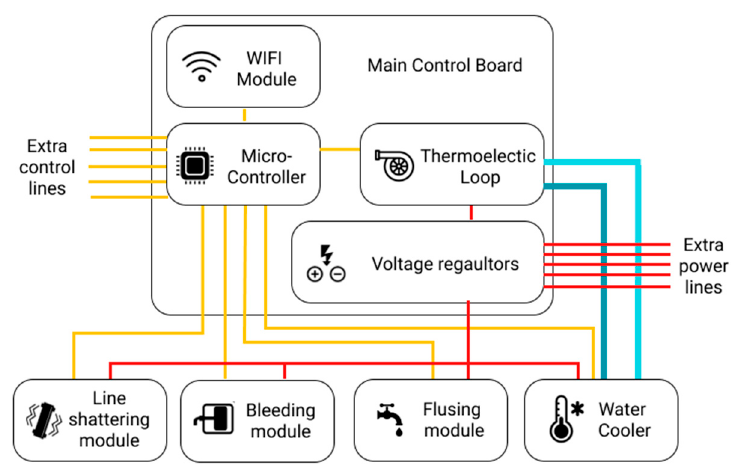
Figure 6. Block diagram of the main control board and module integration.